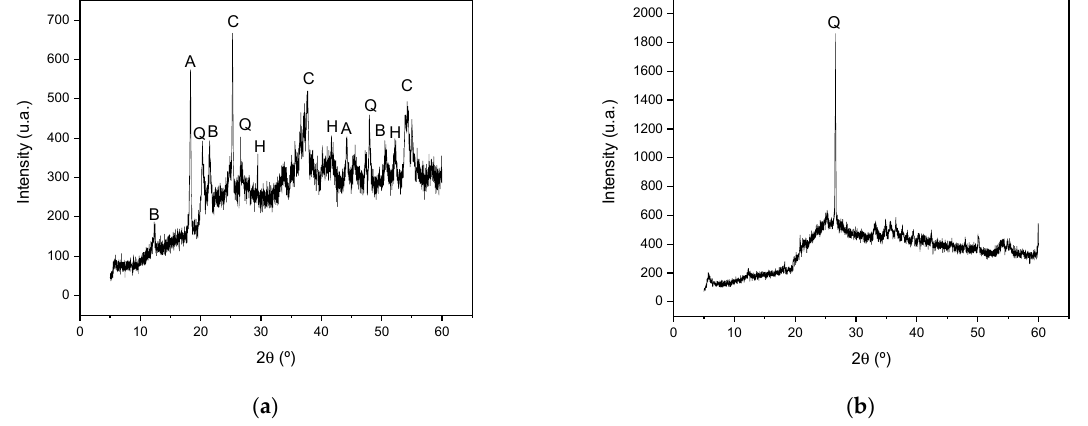
Figure 6. Mineralogical analysis by XRD: ( a ) clay; ( b ) manure used in the production of adobe blocks. Caption: A = anatase; B = brookite; C = kaolinite; H = hematite; Q = quartz.